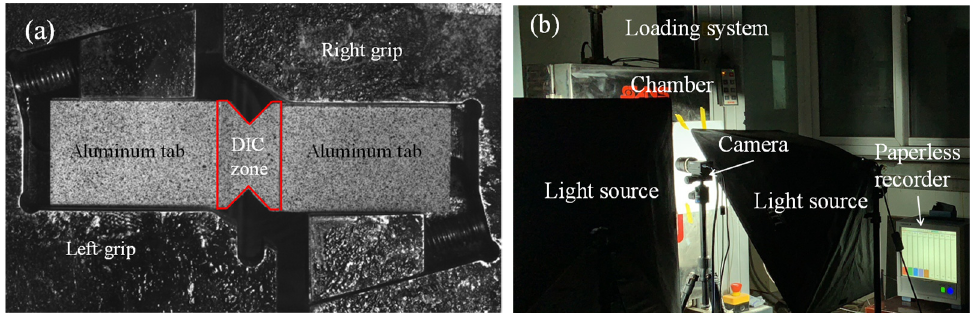
Figure 2. Test setup: ( a ) specimen configuration with DIC zone and ( b ) test systems.